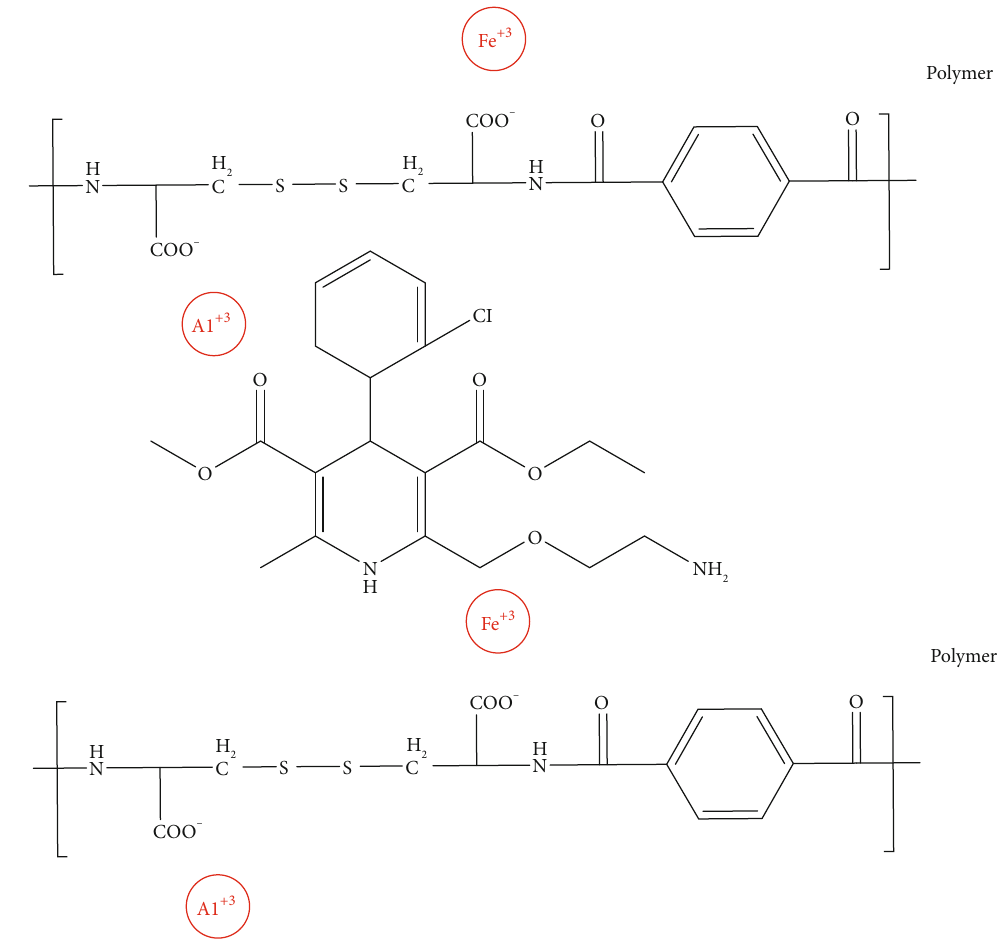
Figure 8: The interaction in Amlop-polymer